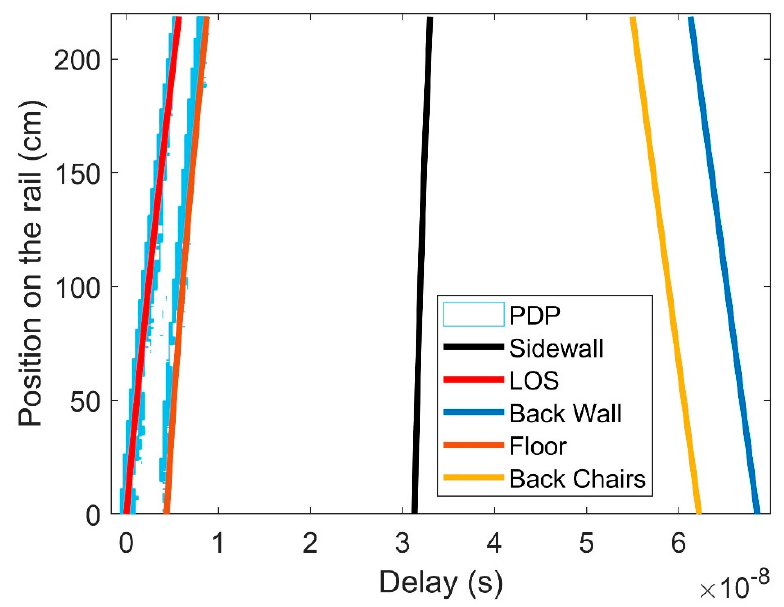
Figure 10. PDP at auditorium, at 60.5 GHz, received by antenna “2”.